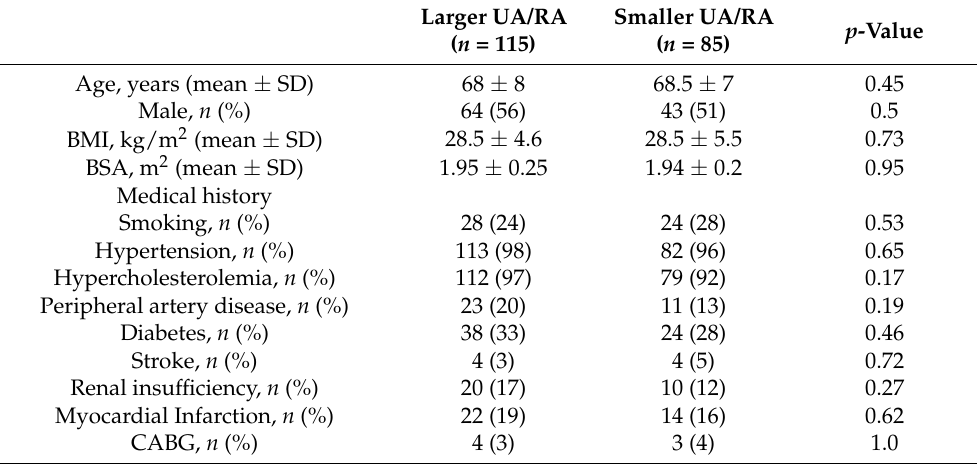
Table 1. Demographic and clinical characteristics of patients, periprocedural characteristics of coronary angiography, and concomitant use of